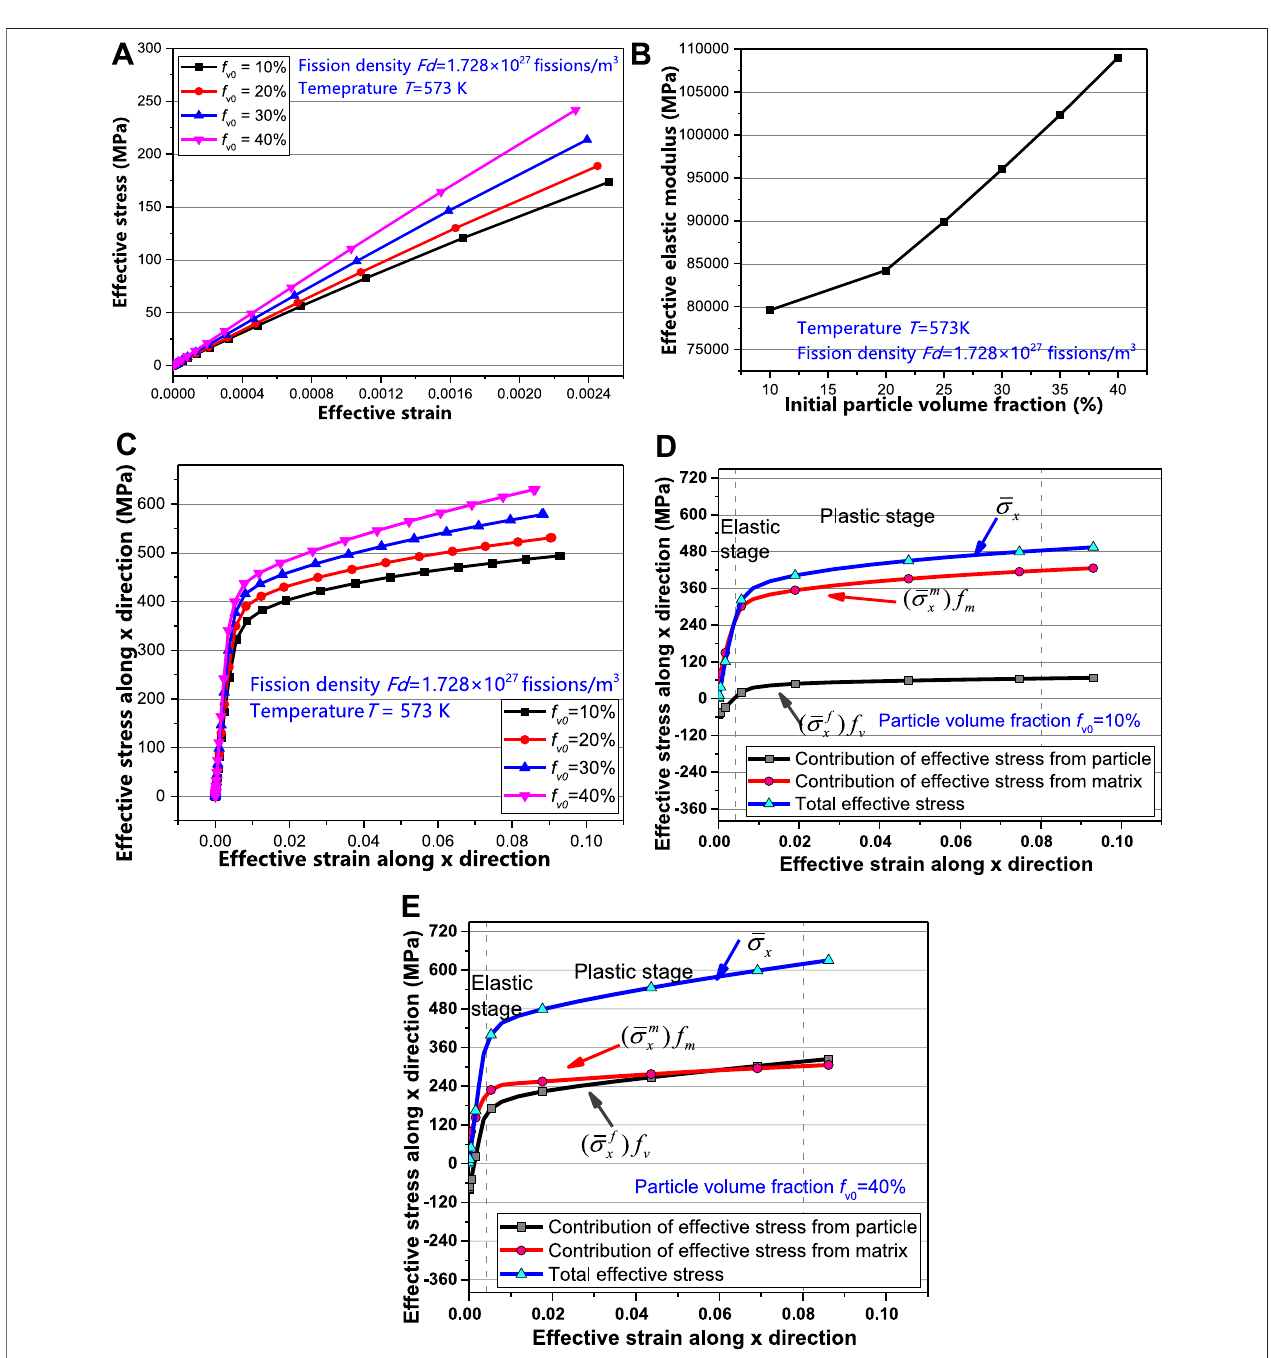
FIGURE 15 | Postirradiation (A) effective stress – strain curves of the elastic stage, (B) elastic modulus,and (C) effective elastoplastic curves under different initial particle volumefractions,theeffectivestress – straincurves,andthecontributionfromtheparticleandmatrixfortheinitialparticlevolumefractionsof (D) 10%and (E) 40%,respectively.